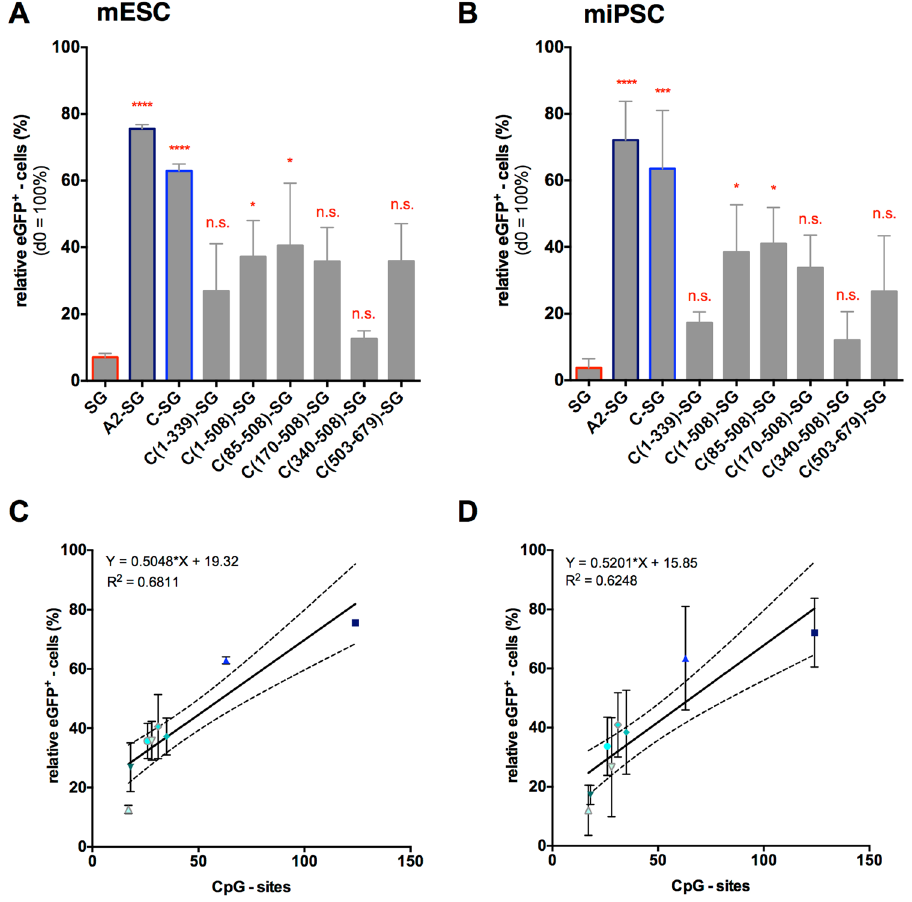
Figure 3. Activity of the CBX3 subfragments in differentiated cells. The transduced cells were subjected to an undirected EB-based differentiation and the eGFP expression was determined on day 0 as well as in SSEA-1 negative cells on day 8. The relative expression of eGFP was determined (d0 = 100%) for ( A ) mESCs and ( B ) miPSCs. (C,D) The correlation of relative eGFP expression in differentiated cells and the number of CpG-sites contained within each element is shown for ( C ) mESCs and ( D ) miPSCs (p < 0.0001). Activity of the subfragments was compared to the SG negative control. Data represent independent experiments n = 3; mean ± SD; * p < 0.05, ** p < 0.01, *** p < 0.001, **** p < 0.0001 as determined by one-way